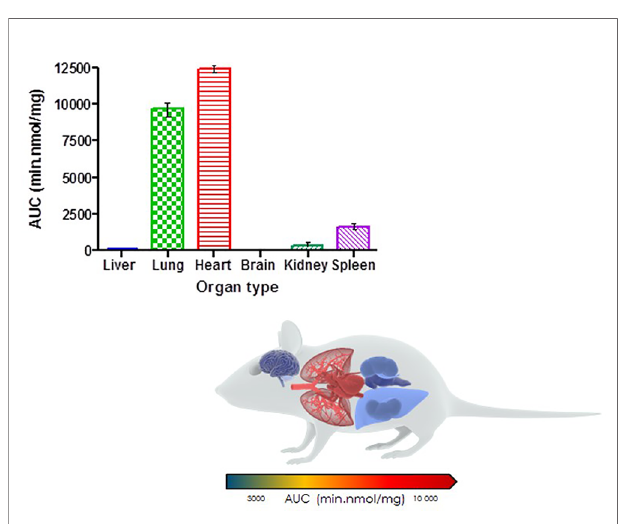
FIGURE 3 | PhX1 exposure in each organ (AUC) (n = 3 per time-point; data presented as means ±